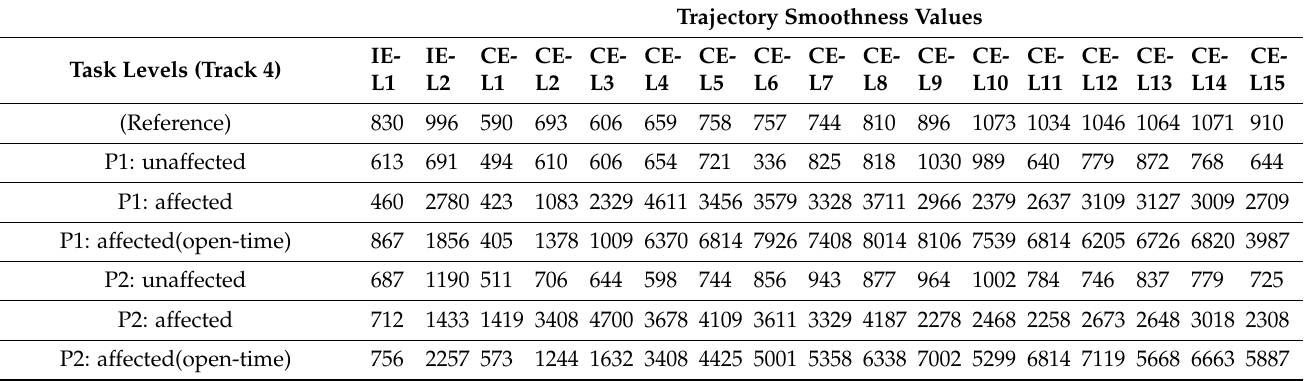
Table 5. The variation of trajectory smoothness parameter with the task levels of both the environ- ments designed on track